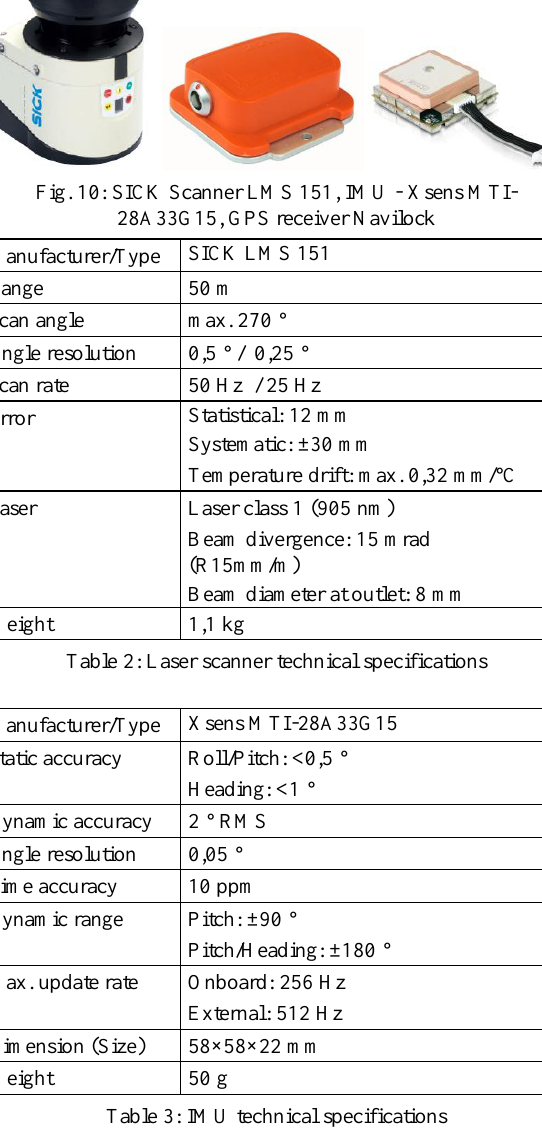
Fig. 9: The measuring system with the gimbal underneath the UAV